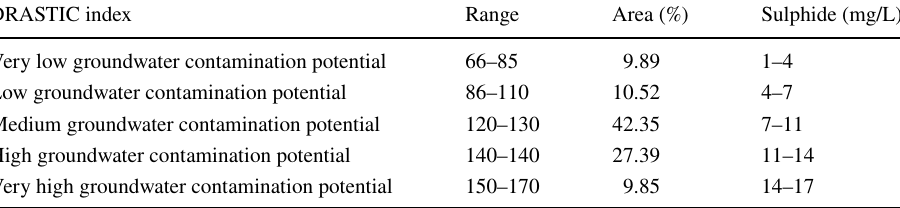
Fig. 10 Groundwater vulnerability contamination map Table 3